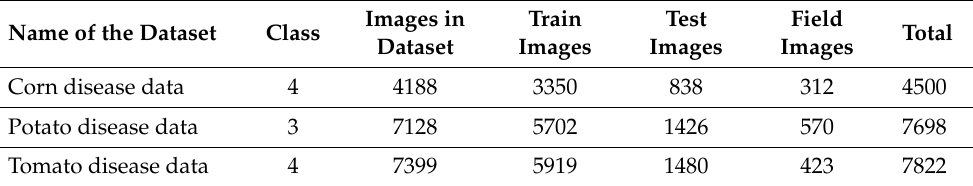
Table 3. Dataset